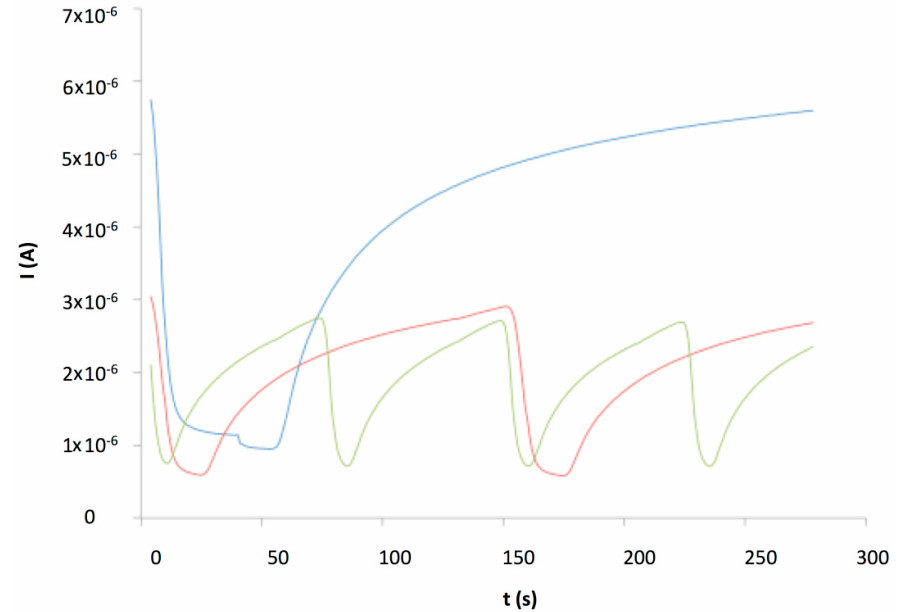
Figure 14. Current versus time of a (PANI/CuTsPc) under 50% RH, with different exposure/recovery times, namely 1 min/4 min ( blue ), 0.5 min/2 min ( red ) and 0.25 min/1 min ( green